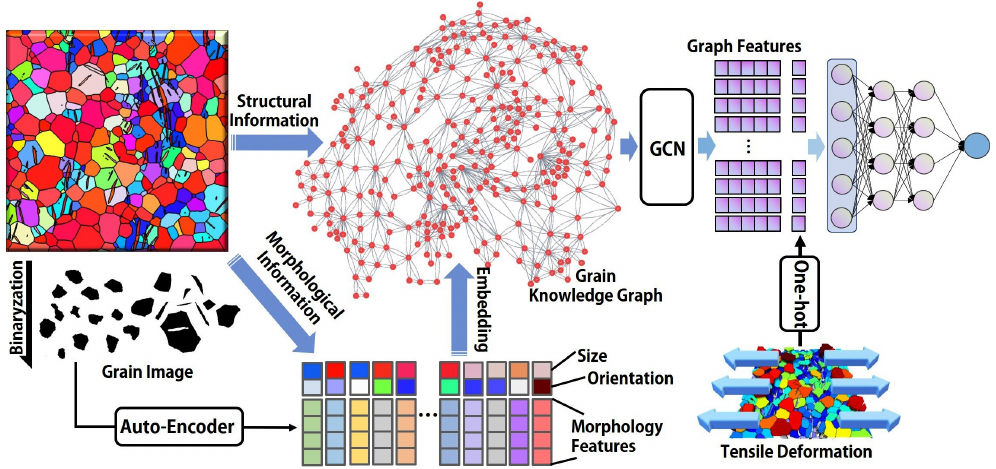
Figure 3. Firstly, each grain is numbered, and the adjacency relationship of each grain is detected to construct the grain knowledge graph. Secondly, an autoencoder is constructed to extract the morphology features of each grain. After that, the grain size and orientation are One-hot coded, which together with the morphology features of the grain is used as the embedding features of the grain. Then, the embedded grain knowledge graph is input into GCN network to extract the graph features. Finally, the tensile deformation One-hot coding applied to the material is input into the prediction network together with graph features, and the twin density of the material after the specified tensile deformation is